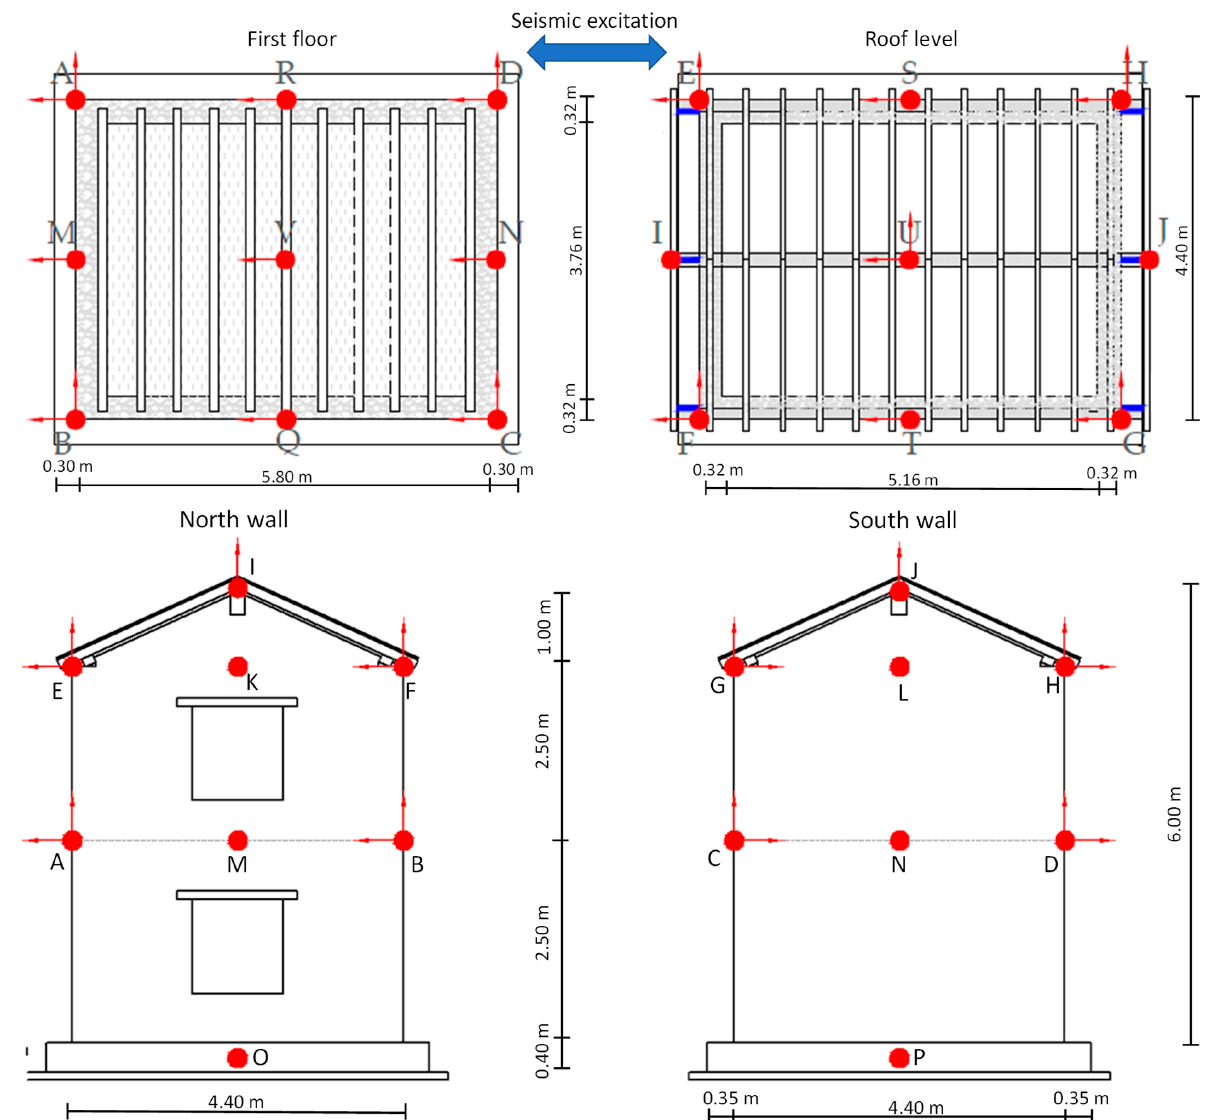
Figure 1. Location of 20 capacitive accelerometers A, B, C, D, E, F, G, H, I, J, M, N, O, P, Q, R, S, T, U and V (red bullets) on the critical positions of the building.